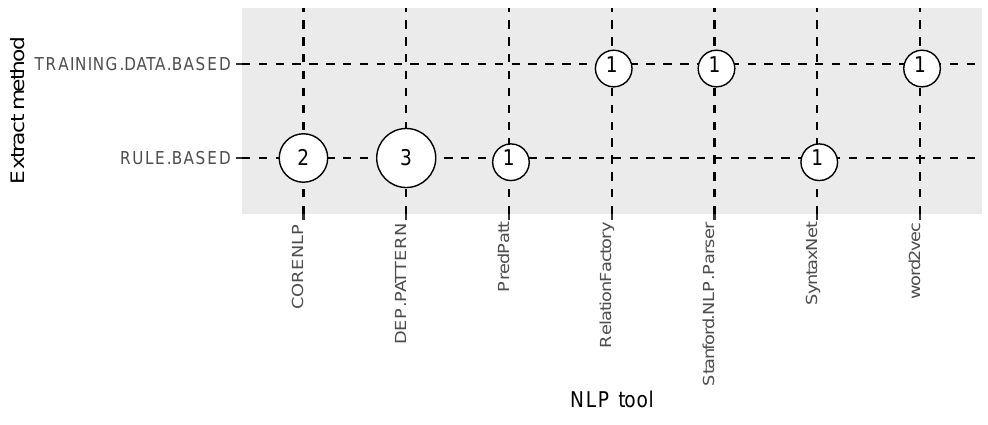
Figure 12. NLP Tool per extract method. (Authors’